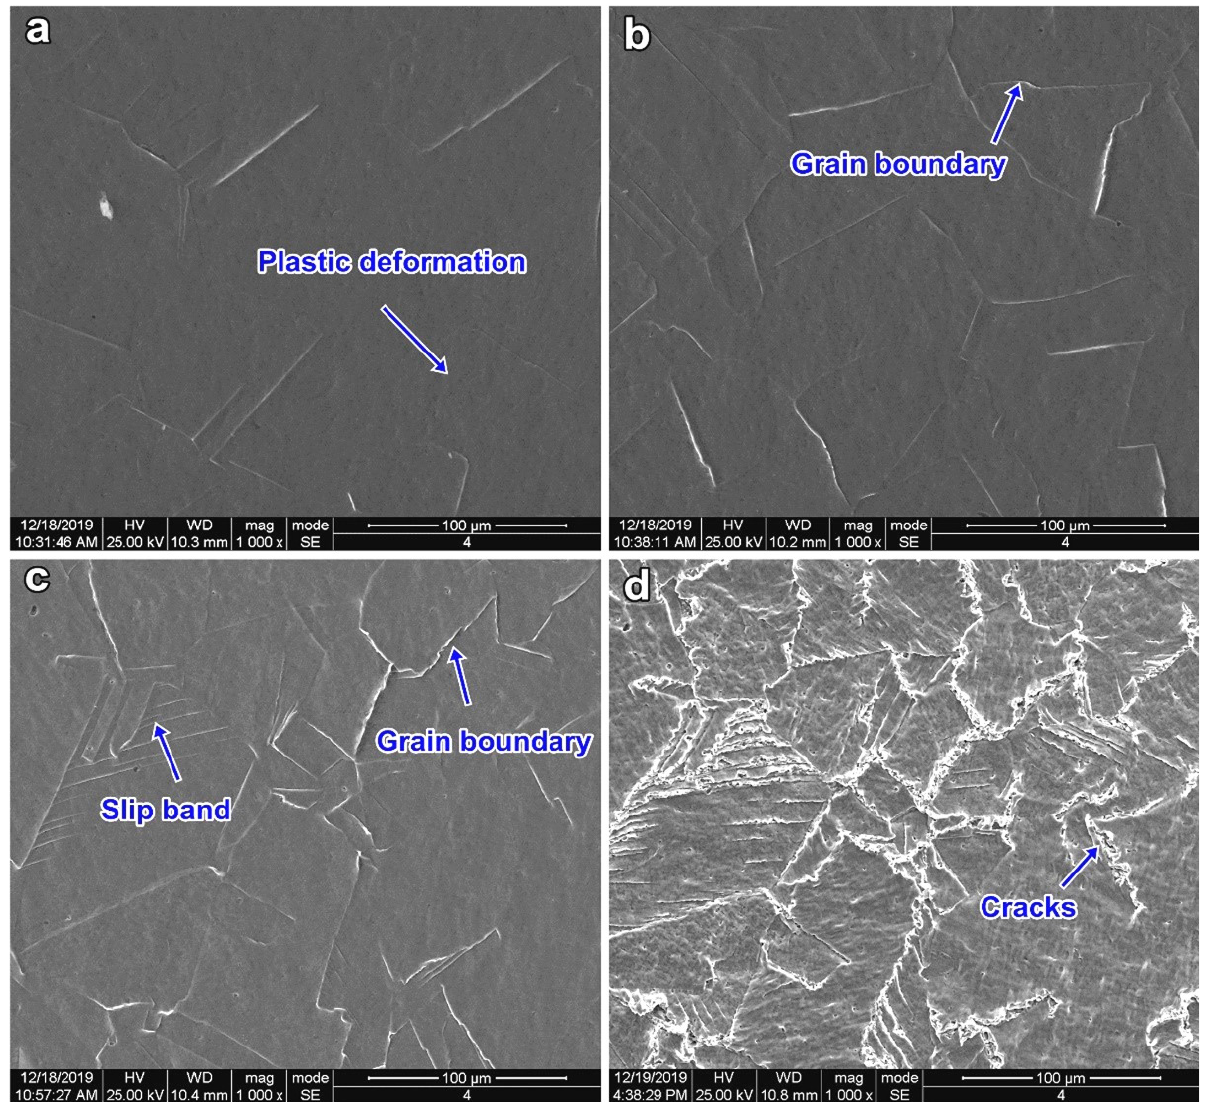
Figure 3. Surface morphologies of 316L SS with different amplitudes of CE: ( a ) 5 μ m for 2 h CE, ( b ) 25 μ m for 2 h CE, ( c ) 55 μ m for 2 h CE and ( d ) 55 μ m for 4 h CE.